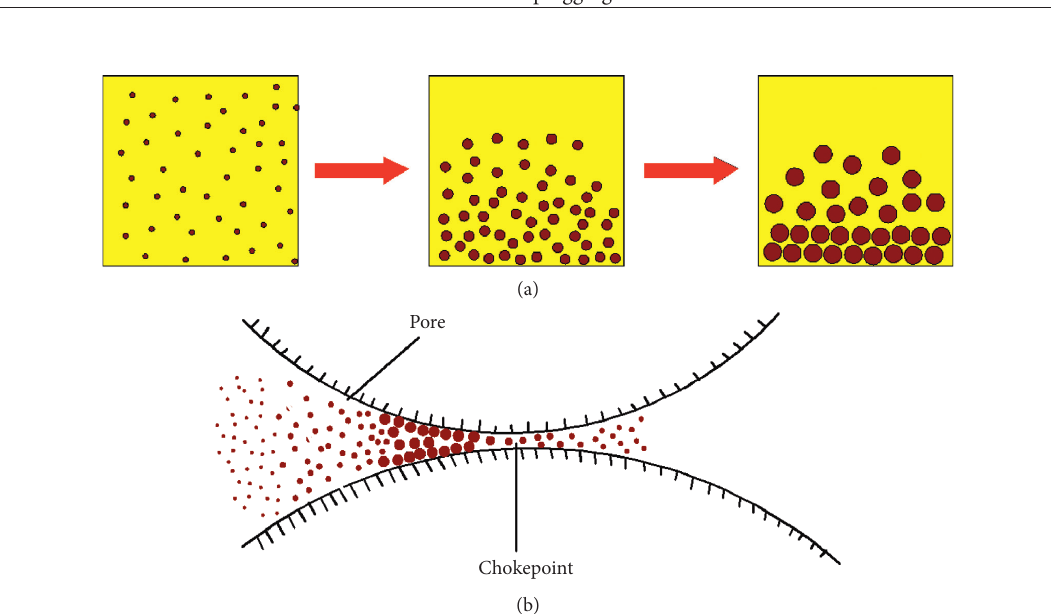
Figure 9: Schematic diagram of the growth and migration of polymeric microspheres through a pore